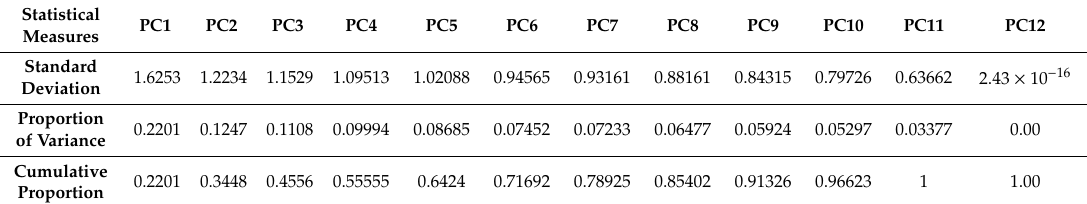
Table 1. Principal Components with Standard Deviation, Proportion of Variance, and Cumulative